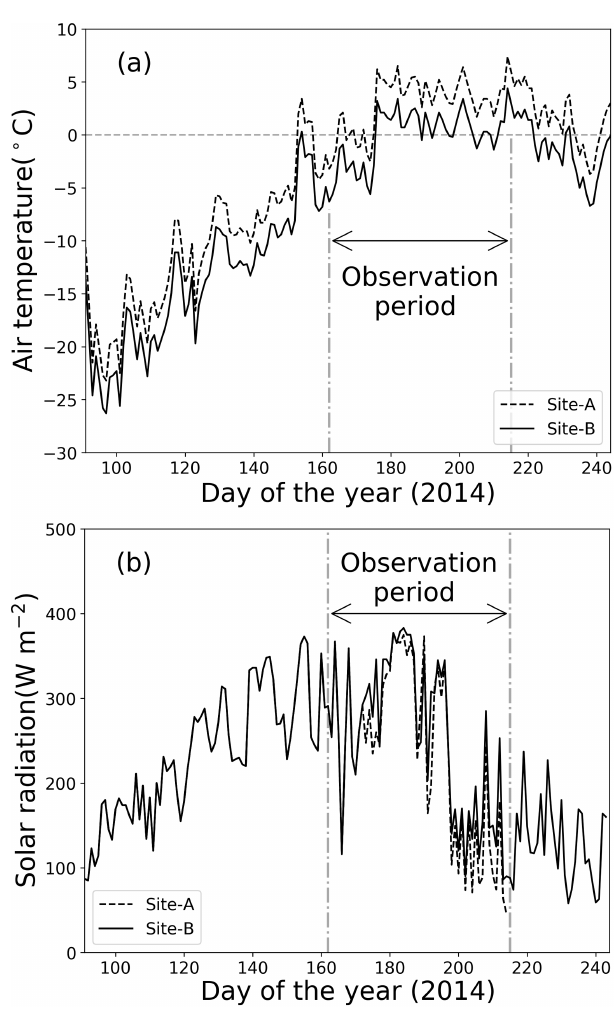
Figure 2. Meteorological conditions at sites A and B from 1 April to 1 September 2014. (a) Daily mean air temperature, (b) solar ra- diation.